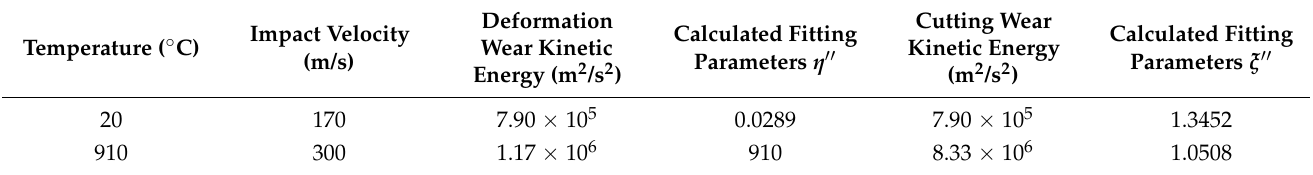
Table 3. The fitted parameters η (cid:48)(cid:48) and ξ (cid:48)(cid:48) based on deformation wear kinetic energy φ and cutting wear kinetic energy ε